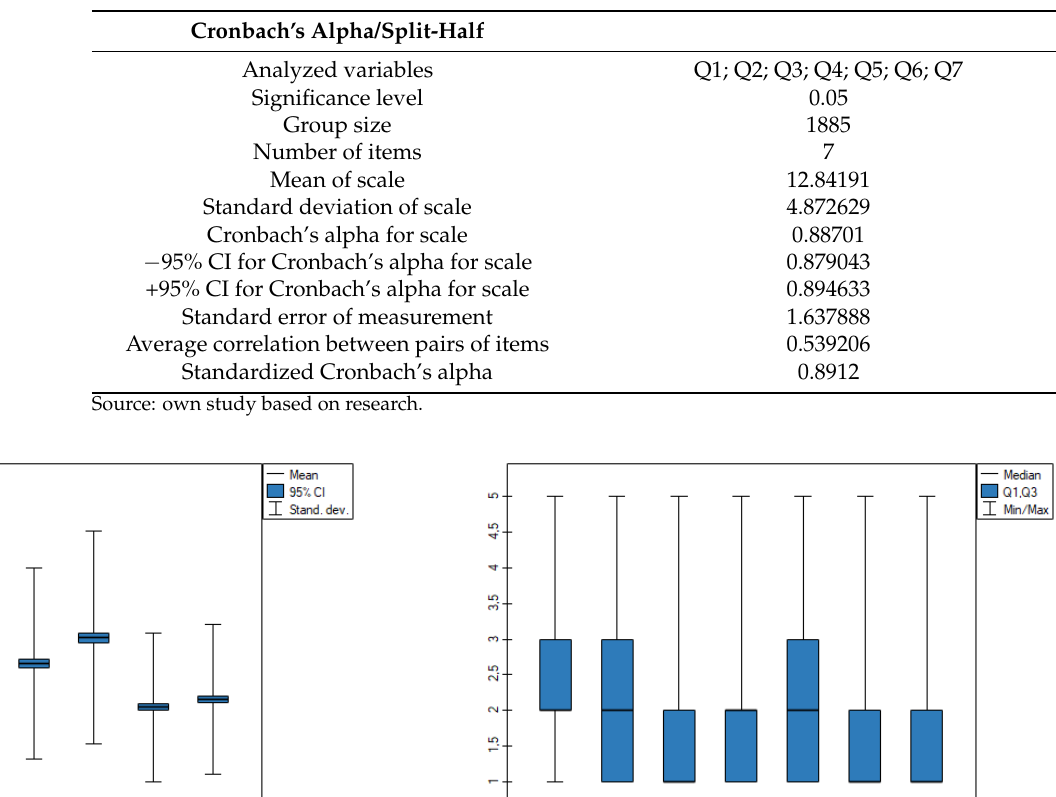
Table 1. Cronbach’s alpha test.